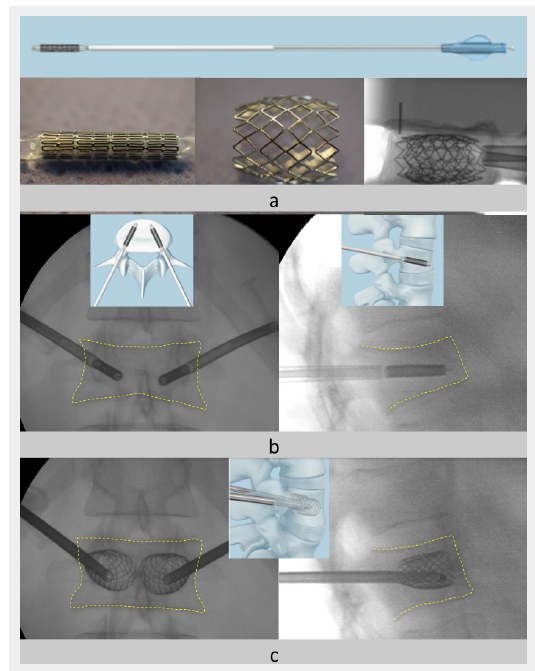
The vertebral body stent principle: A 4 mm stent with different lengths can be expanded up to 400%. It can provide preliminary stability and maintain the height gain before cement is injected; it cannot work as a standalone device (a). The stents are placed on each side through the pedicles (b). The stent is then expanded by the balloon. In this way the vertebral height (c) is restored. The final stabilisation is performed by the injection of bone cement (not shown here). The contours of the vertebral body are outlined by the yellow dashed lines.